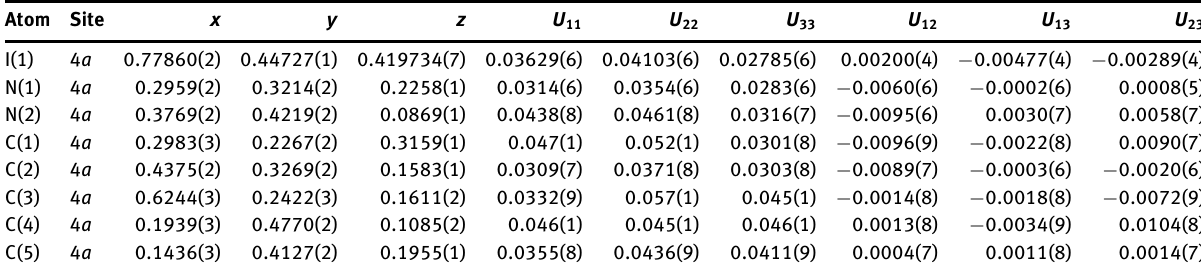
Table 3: Atomic coordinates and displacement parameters (in Å 2